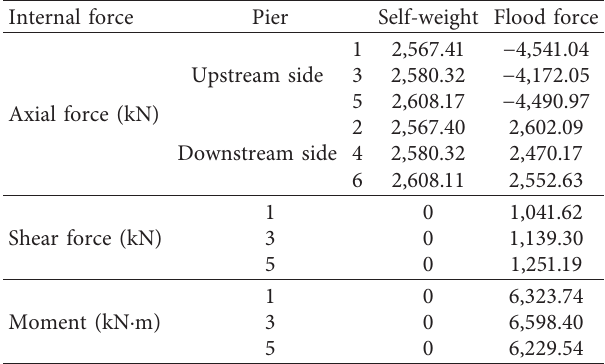
Figure 18: Arrangement of the piers. Table 7: Internal force of the